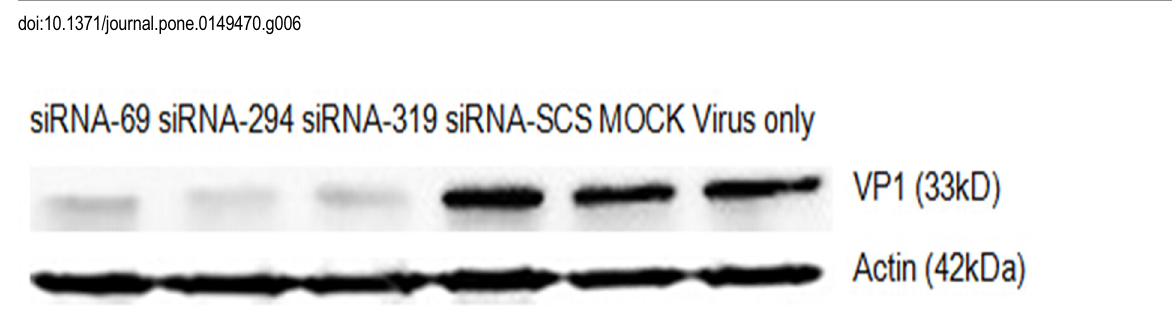
Fig 7. RNAi inhibits the replication of different EV71 strains. RD cells transfected with siRNA were infected with strain EV71-2008-43-16 at an MOI of 0.01. Total protein was extracted at 36 h after infection, and VP1 expression was analyzed with western blotting. β -Actin was used as the internal loading control. Protein measurements were made in three independent